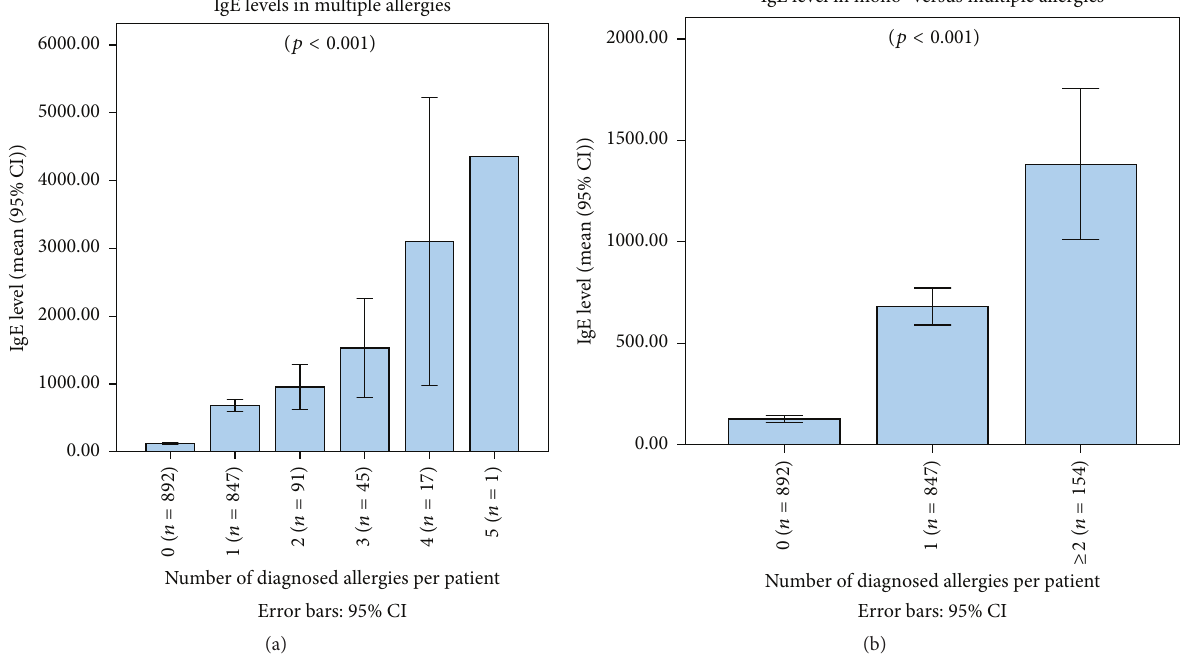
Figure 2: Mean (95% CI) total IgE levels in correlation with the number of allergens identified, showing (a) an increase in total IgE levels with the number of allergens ( 𝑝 < 0.001 ) and (b) a higher level of total IgE in cases of multiple ( ≥ 2) allergens versus one single allergen versus absence of allergen ( 𝑝 < 0.001